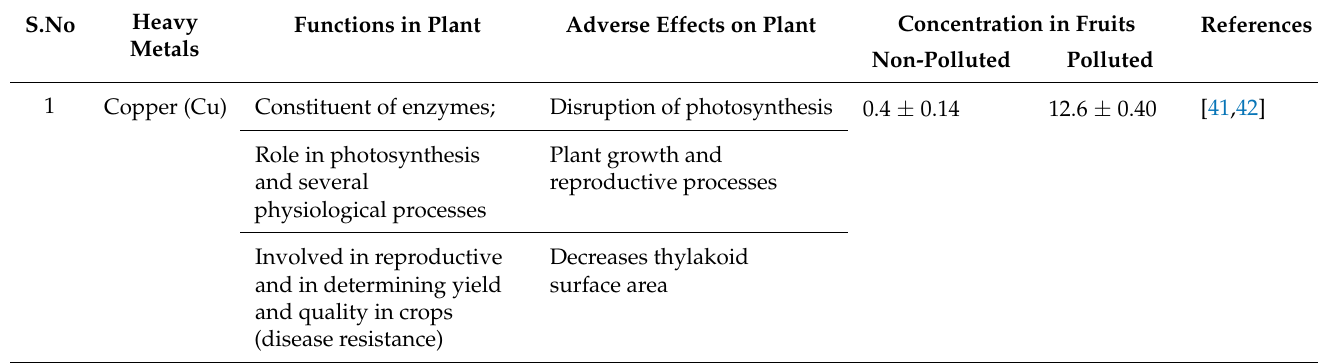
Table 1. Functions and effects of heavy metals on plant growth and their concentrations in